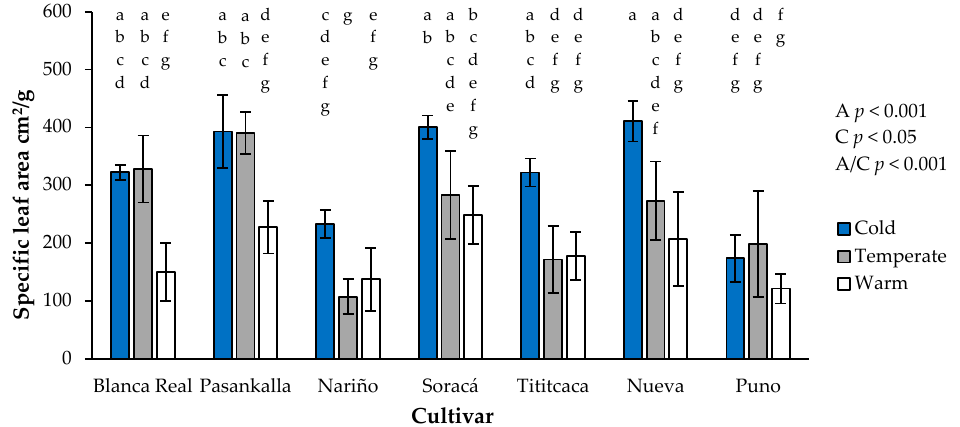
Figure 3. Specific leaf area performance of different quinoa cultivars subjected to three altitude gradients. The bars indicate standard error. Different letters indicate significant differences. A: Altitudinal; C: Cultivar; A/C: Altitudinal/Cultivar.